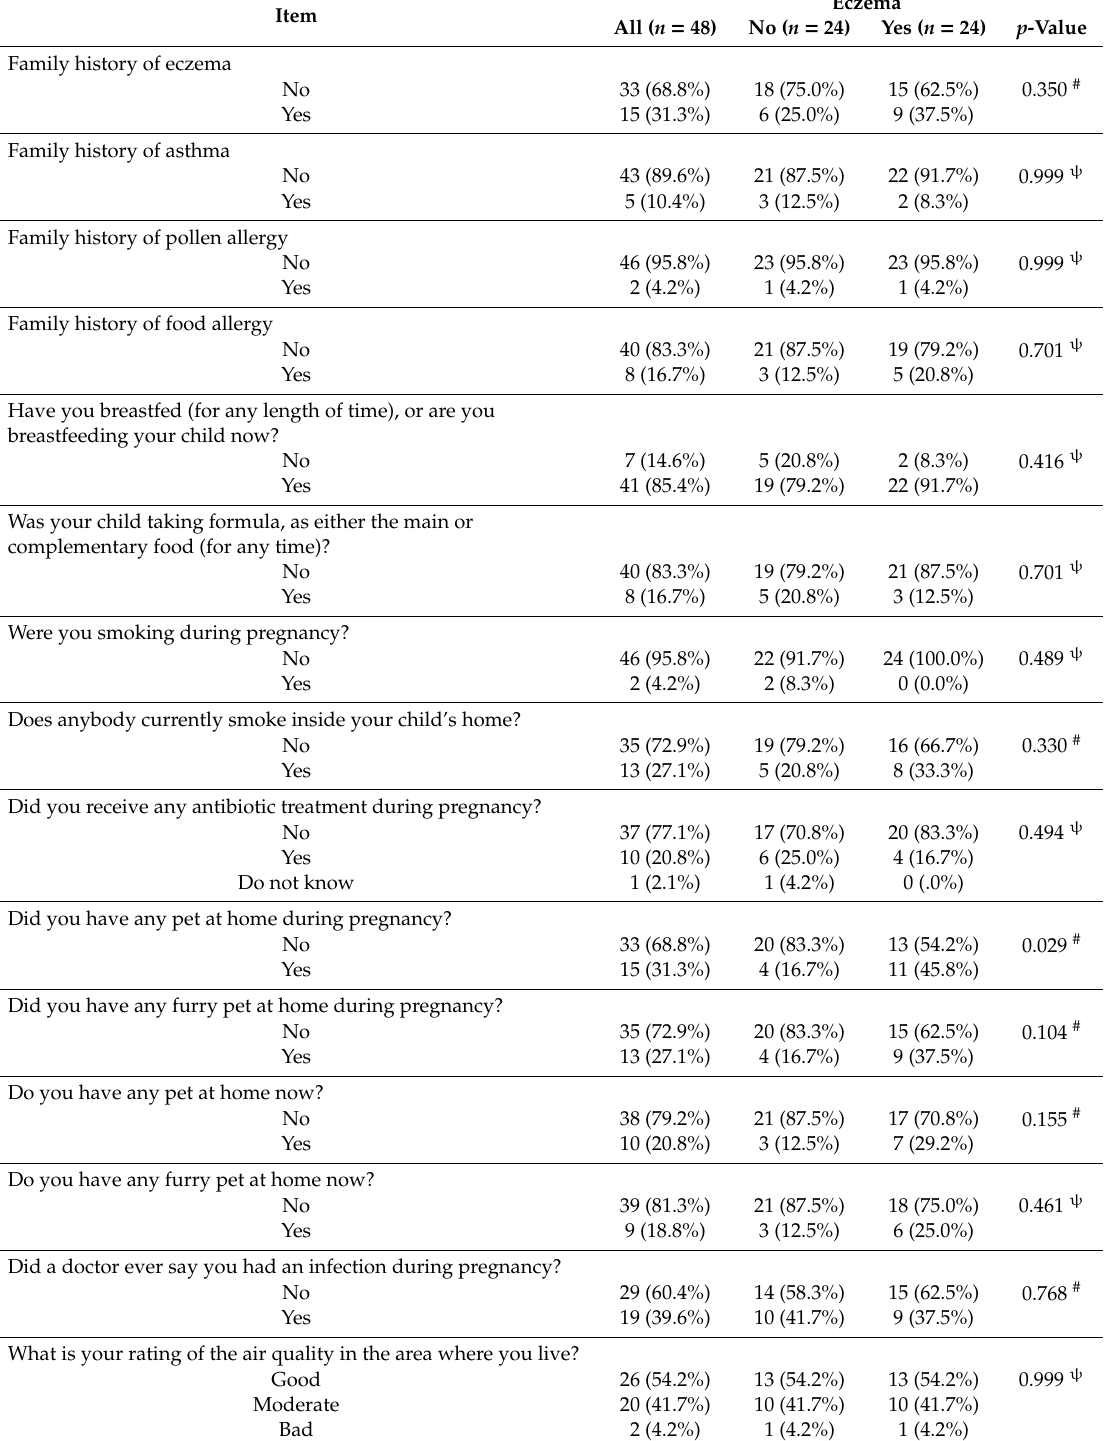
Table 5. Allergy data of 48